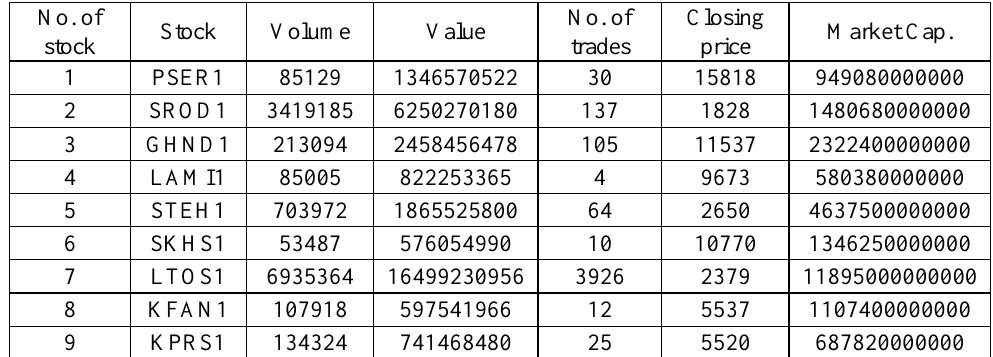
Table 4. The data of several characteristics of